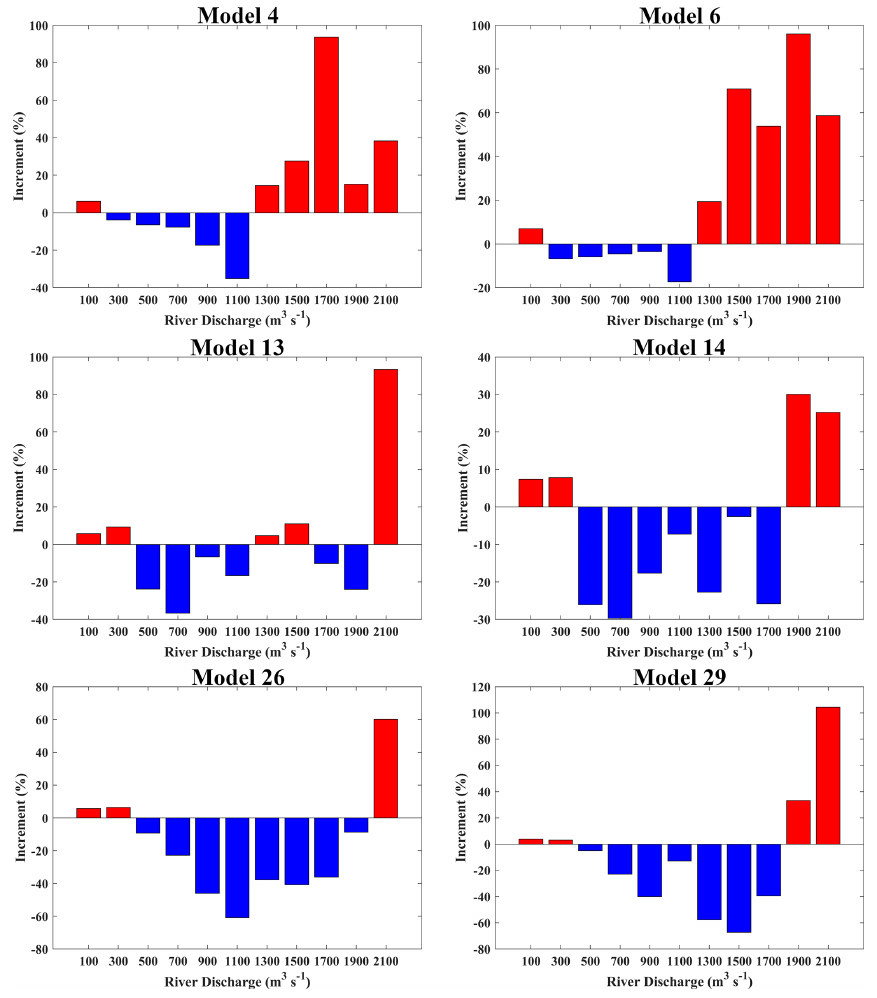
Figure 5. Percentage of change in the frequency of river flow ranges in the future with respect to the historical period for each valid model. The river flow data were distributed in ranges of 200m 3 s − 1 . Each value of the river discharge indicates the mean of the corresponding range (100m 3 s − 1 corresponds to the range of 0–200m 3 s − 1 ). In the last range (2100m 3 s − 1 ), the river flows surpassing the alert threshold (2000m 3 s − 1 ) are included. Positive (negative) values indicate increase (decrease) in the